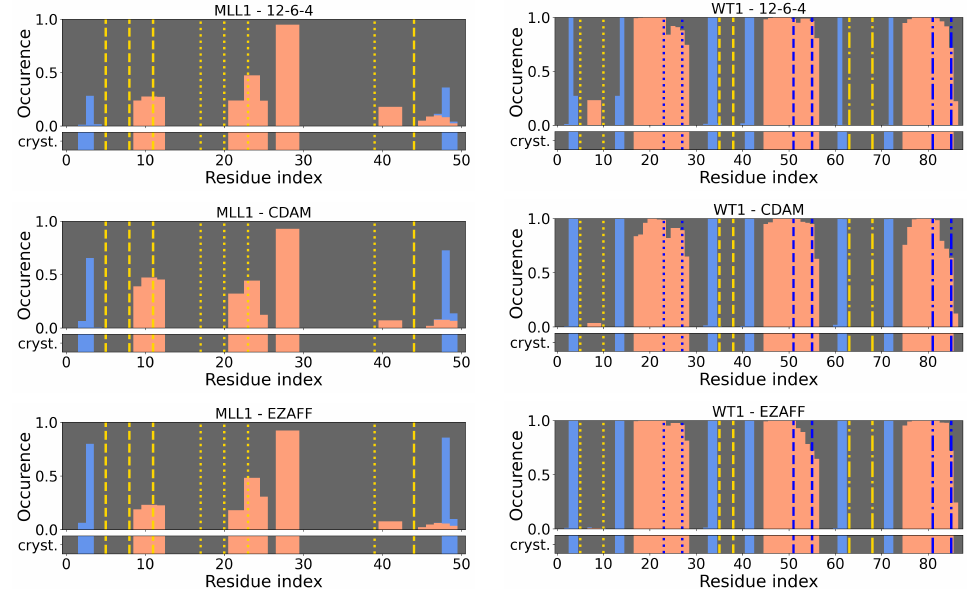
Figure 4. Percentage of secondary structure elements for all protein residues; helices are shown in light red, sheets in light blue, and everything else in grey. Coordinating cysteines are shown in yellow and histidines in blue. The residues coordinating ZN1, ZN2, and ZN3 are indicated as dotted, dashed, and dash-dotted lines, respectively. The secondary structure of the corresponding crystal structure is also shown in each figure. For residue names of coordinating residues, see Table